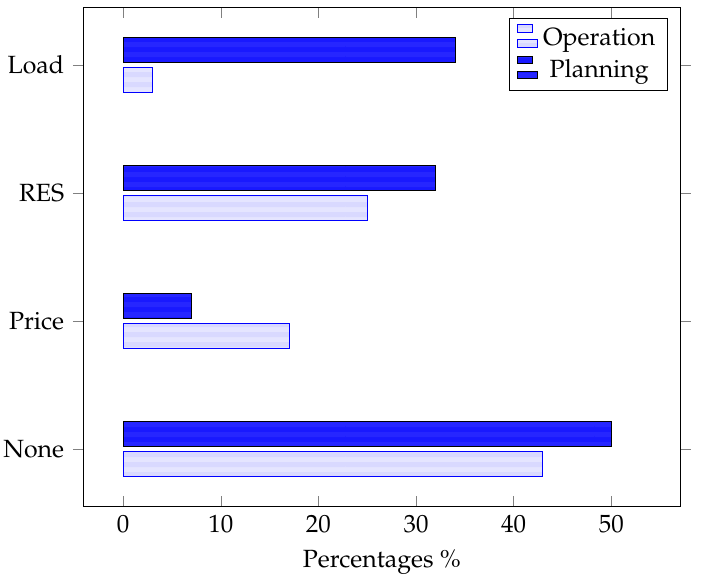
Figure 7. Sources of uncertainties in the reviewed operational and planning models (the sample contains 70 operational and 55 planning